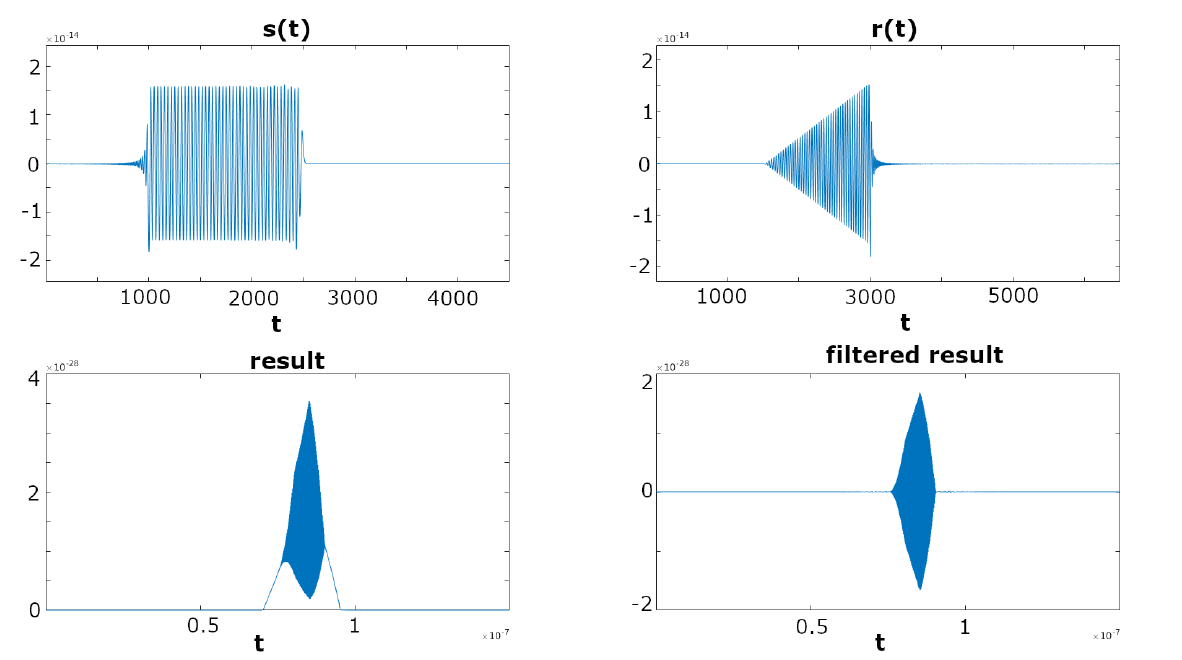
Figure 2. In the first row, s ( t ) is the square signal, and next to this function is the triangular signal r ( t ) (inverted in time). These are traveling opposite each other. The first plot in the second row is the raw result, which is read from the collision of the above signals. The last plot is the frequency-filtered result, which had a doubled frequency compared with the original